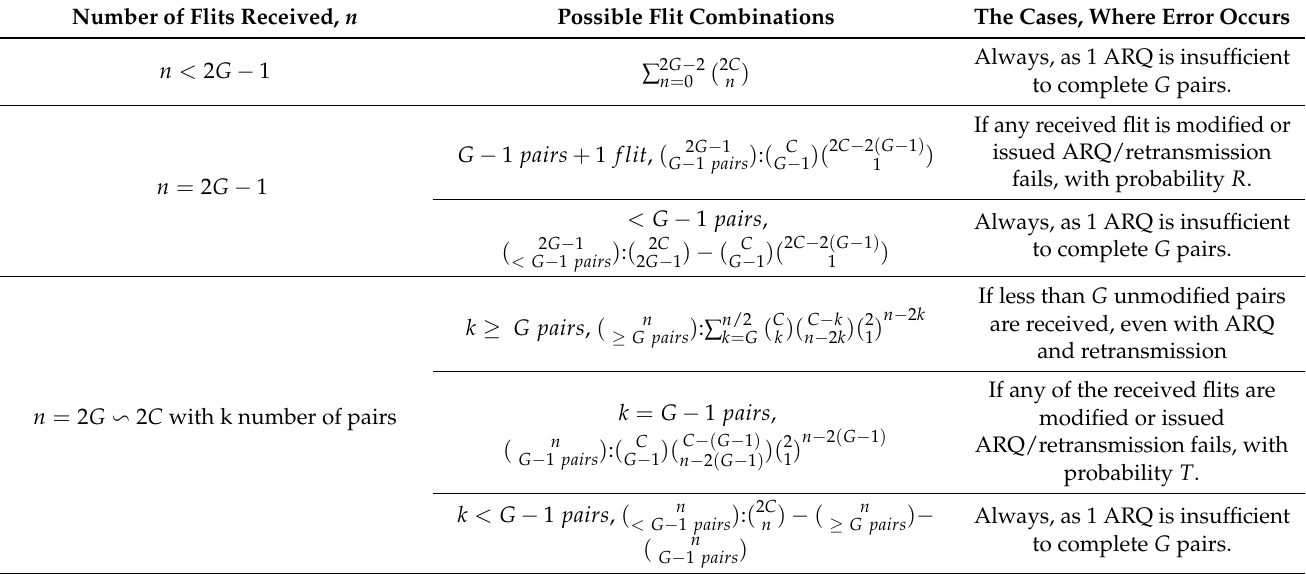
Table 4. Error cases for NC transmission with S1 authentication